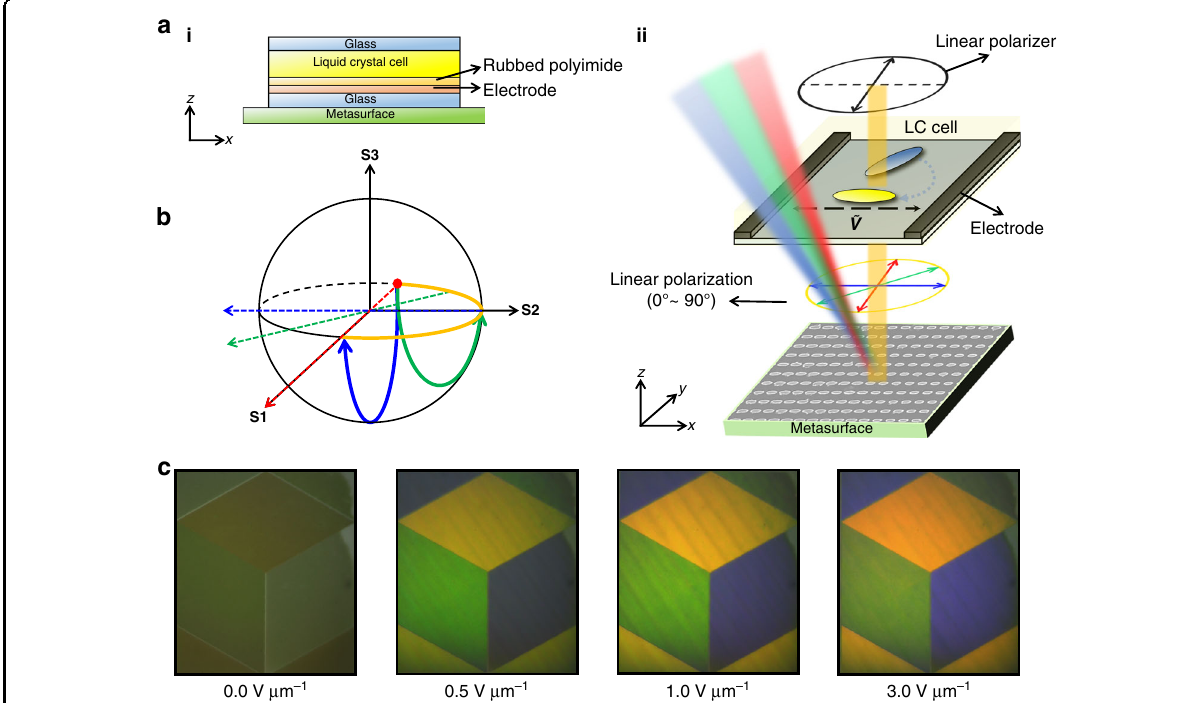
Fig. 4 Liquid crystal design and integration. a Schematic illustration of the LC integrated metasurface. (ii) Incident LP is modulated through the LC cell. The orientation of LCs at E = 0.0 and = 3.0 V µm − 1 is denoted by blue and yellow molecules, respectively. b Poincare sphere representing the change in LP state. The solid blue and green lines describe the polarization transitions at E = 0.0 and 0.4 V µm − 1 , respectively, with the rotation axis of the Poincare sphere (dotted lines). The orange line indicates the range of LP states that we manipulate. c Experimental demonstration of electrically tunable cryptographic images using LC integrated polarization sensitive metasurfaces. The brightness of the image is electrically tuned from dark black to bright colors using an external bias from E = 0.0 to 3.0 V µm −